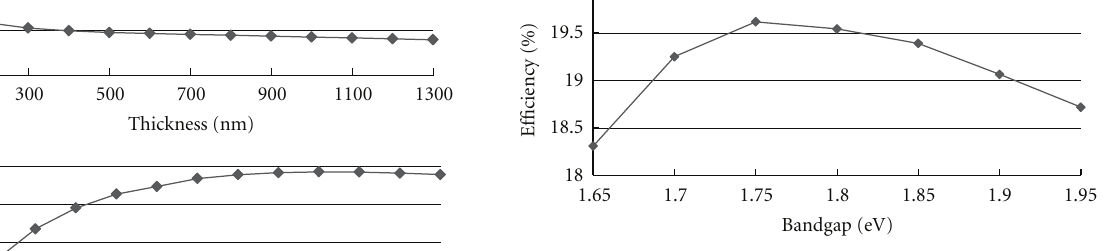
Figure 3: E ff ect of i-layer bandgap on cell performance.